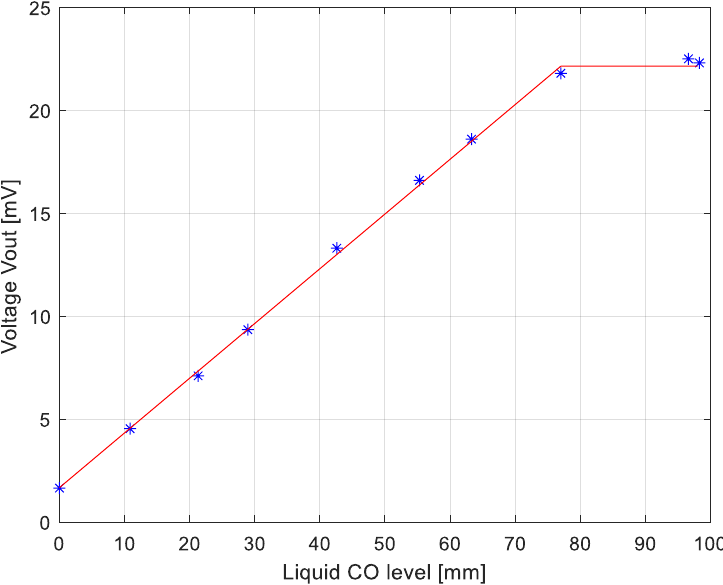
Figure 5. Liquid CO-level transducer: experimental data (stars) and theoretical results (solid line).